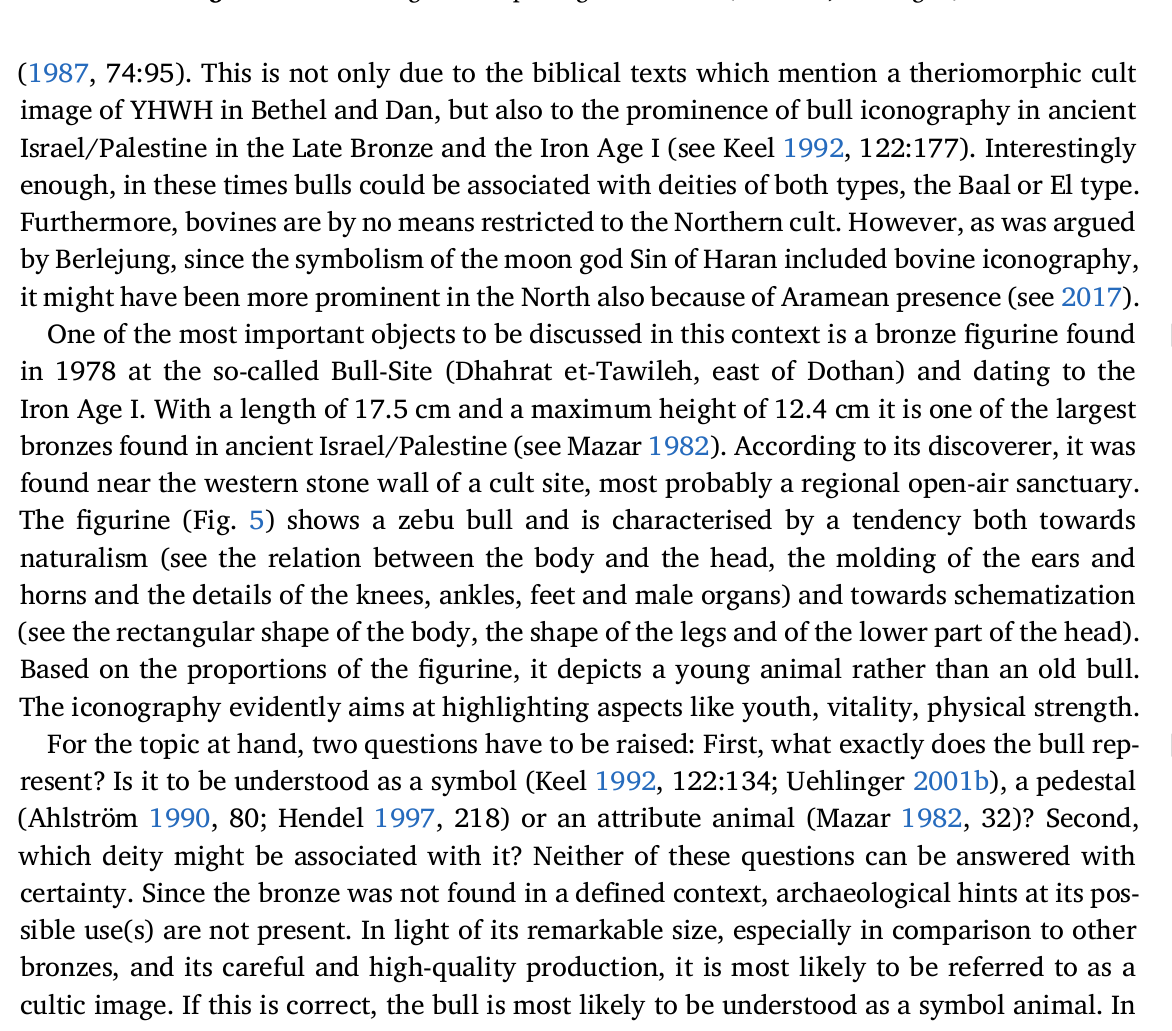
Figure 5 Bronze figurine depicting a zebu bull (Bull-Site, Iron Age